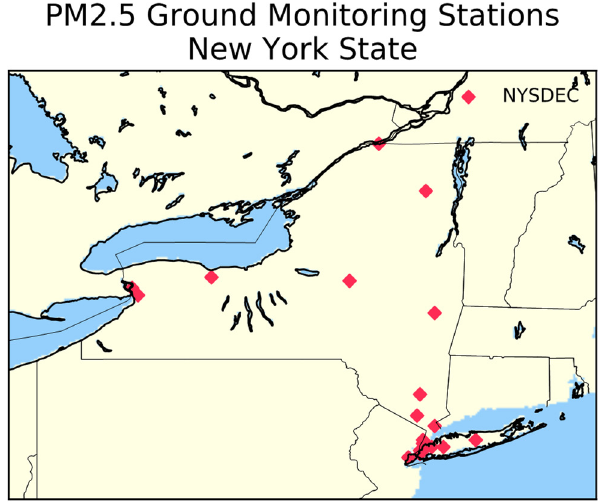
Figure 1. Locations of the New York State Department of Environment Conservation (NYSDEC) stations.